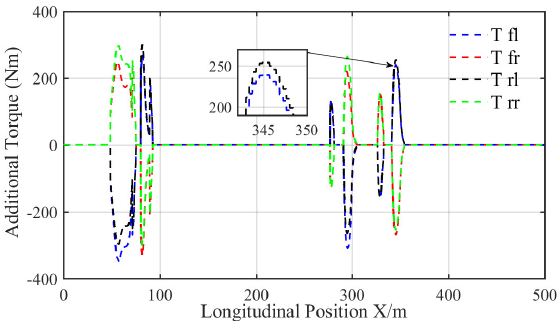
Figure 12. Additional torque of the path tracking stability controller at lower speed ( V x = 80km/h).